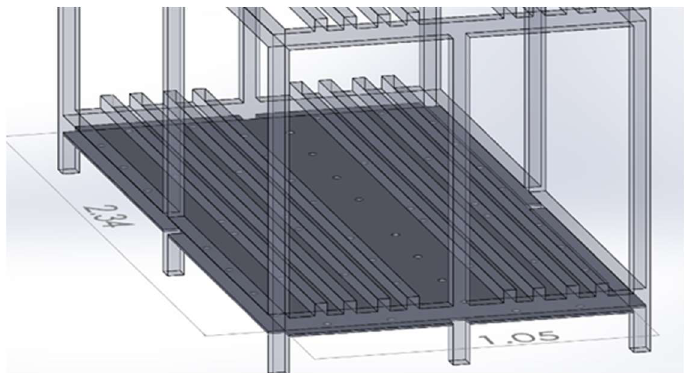
Figure 3. Vent plate attached to the bottom the rack. All perforations are circular and 3 mm in diameter. Dimensions are in meters.